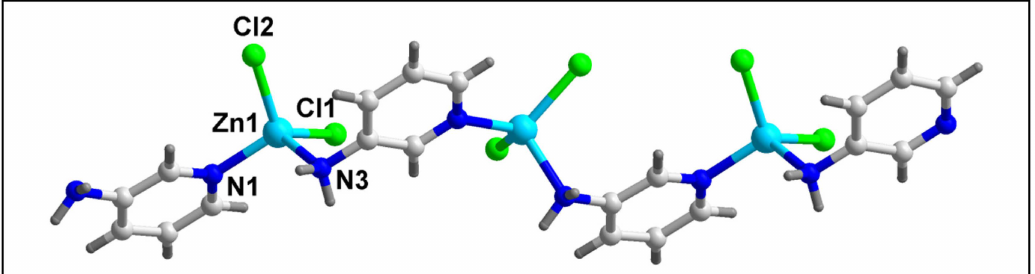
Figure 4. Molecular structure of [ZnCl 2 ( µ -3-AmPy) 2 ] n ( 2